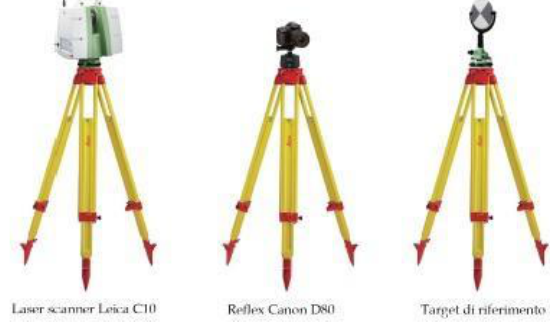
Figure 4. Topographic instruments for the surveying